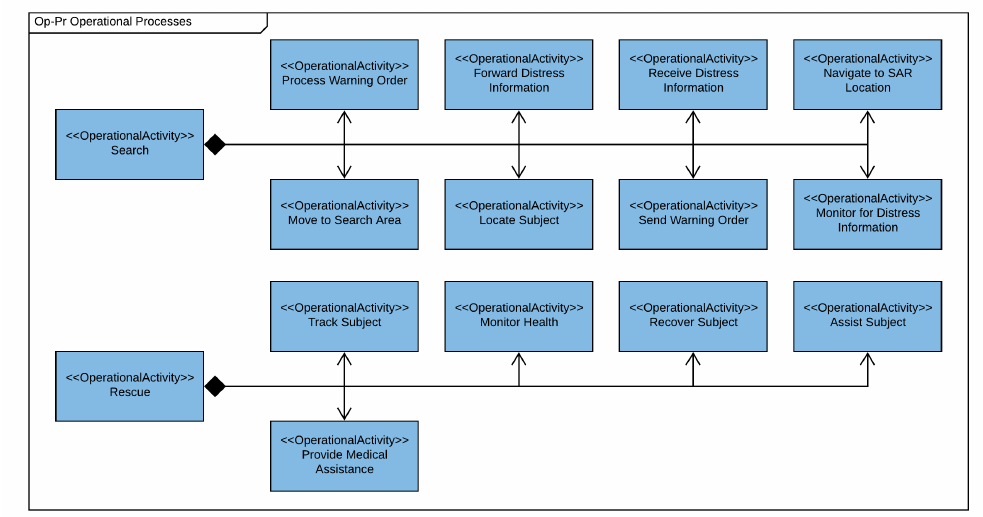
Figure 9. The Operational Processes (Op-Pr) view of the UAF, which describes the hierarchy of operational